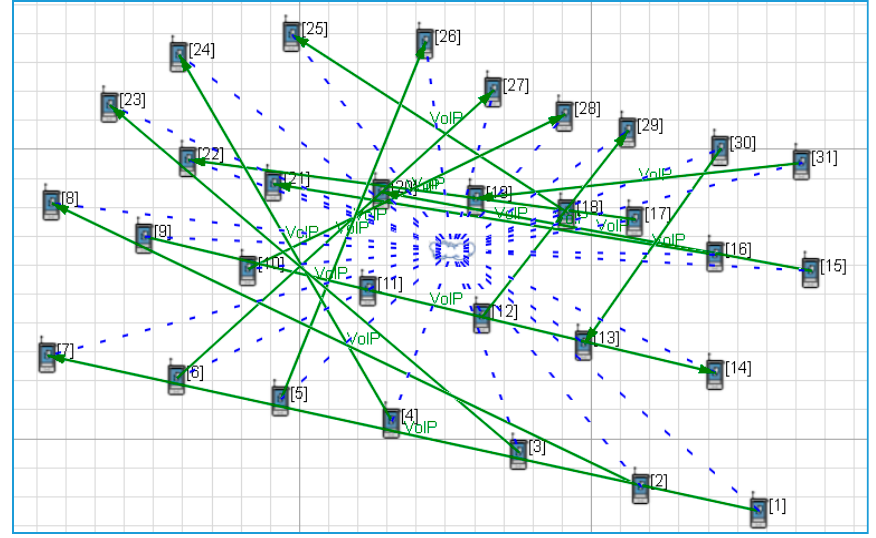
Figure 9. Flooded village scenario.